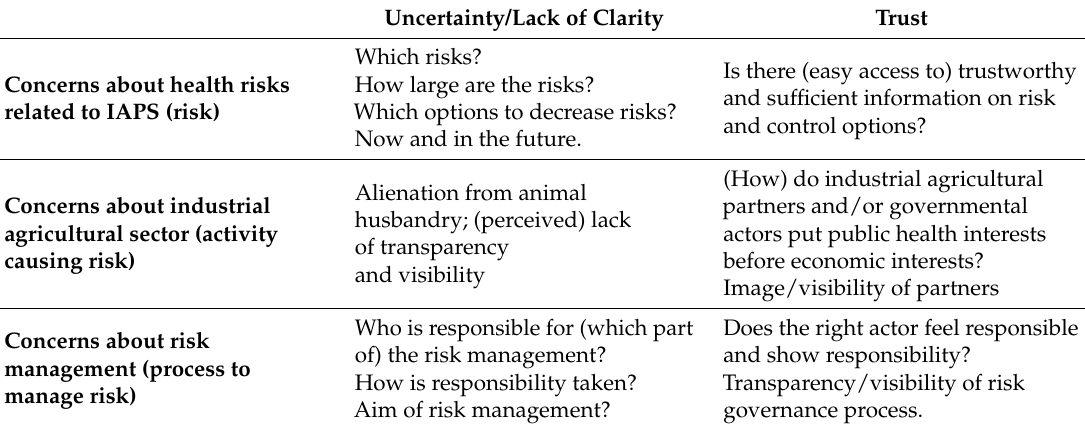
Table 1. Differentiation of concerns involved in the debate on IAPS and